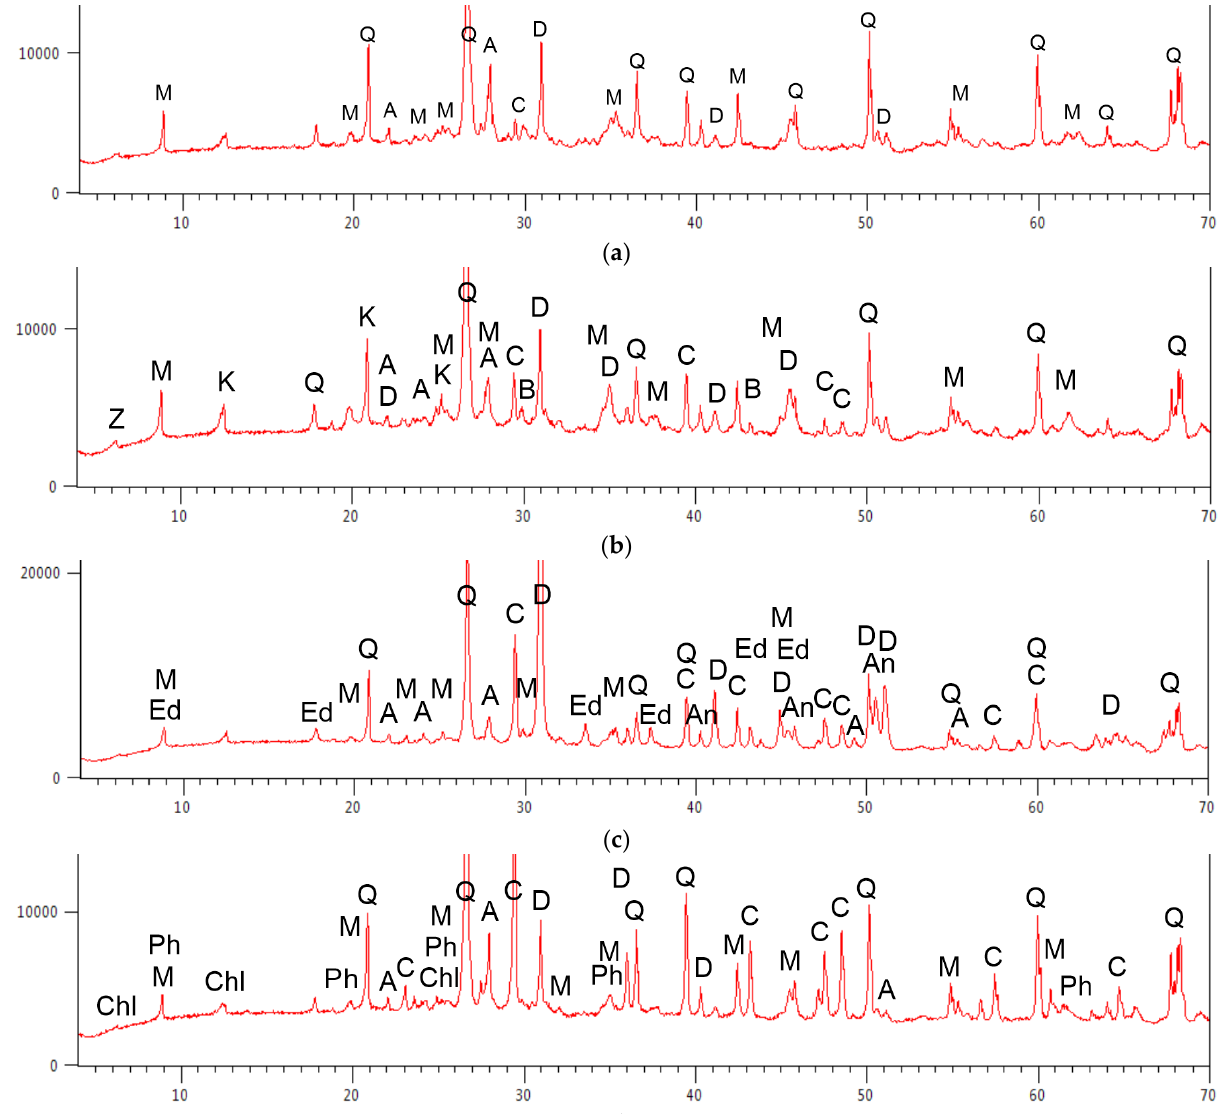
Figure 8. Obtained X-ray diffraction patterns for the samples where the highest values of factor scores were determined for the finer fraction (<0.063 mm) for the F1 ( a ), F2 ( b ), F3 ( c ) and F4 ( d ). The key for peak indicators is presented in Table 3. Table 3. The results of X-ray diffraction analysis for samples (<0.063 mm only) where the highest values of factor F1–F4 scores were calculated.